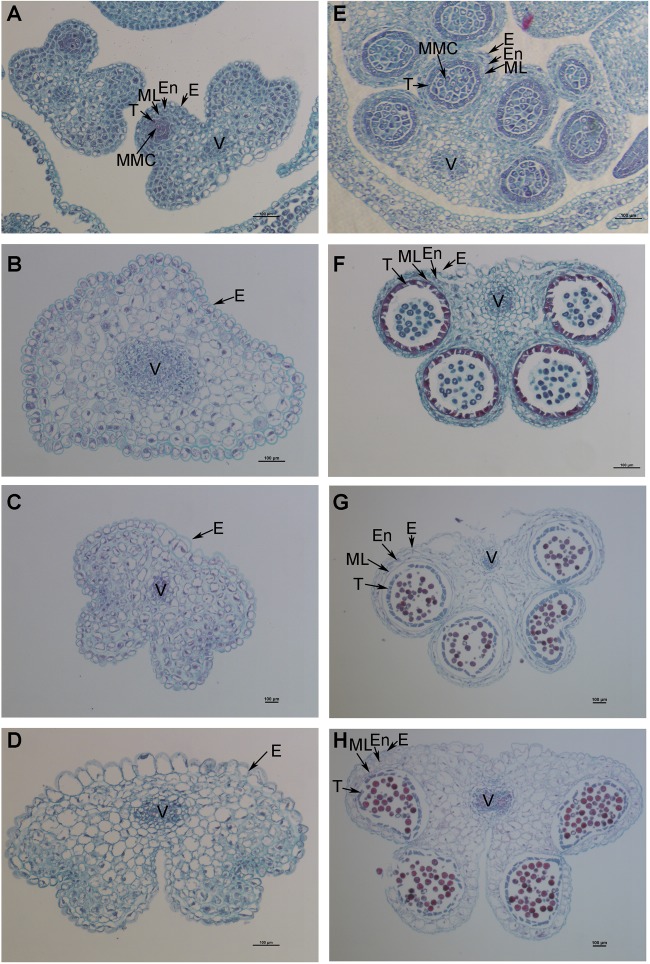
Dynamic observation of paraffin sections of Shaan2A and Shaan2B anthers. (A) Anthers in 1 mm buds of Shaan2A. (B) Anthers in 2 mm buds of Shaan2A. (C) Anthers in 3 mm buds of Shaan2A. (D) Anthers in 4 mm buds of Shaan2A. (E) Anthers in 1 mm buds of Shaan2B. (F) Anthers in 2 mm buds of Shaan2B. (G) Anthers in 3 mm buds of Shaan2B. (H) Anthers in 4 mm buds of Shaan2B. E, epidermis; En, endothecium; ML, middle layer; T, tapetum; MMC, microspore mother cells; V, vascular region. Bar: 100 μm.